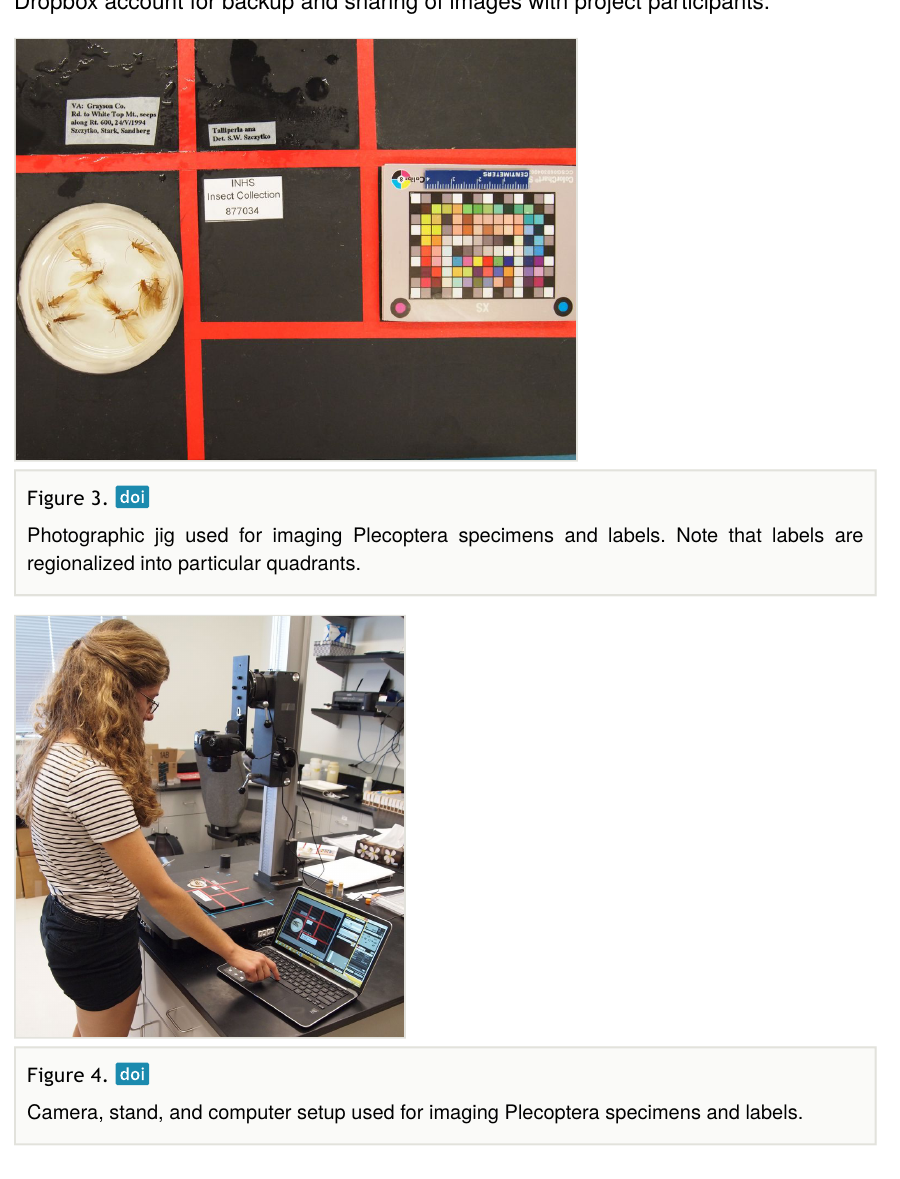
other labels, a color standard, scale, and metadata tag consisting of name of photographer, date imaged, and donor name (Fig. 3). The imaging jig layout corresponds with an image processing library ("sqed", https://github.com/SpeciesFileGroup/sqed) developed for future integration of the images into collections management software. Images of up to 20 MB were captured without fl ash using a Canon EOS 6D camera with a 50 mm lens, mounted on a Polaroid MP-4 photographic stand (Fig. 4). Imaging was coordinated through a Dell XPS 13 laptop equipped with EOS 6D Utility software. Images for each session were temporarily stored on this computer in a folder labelled by date and transferred to a Dropbox account for backup and sharing of images with project participants.